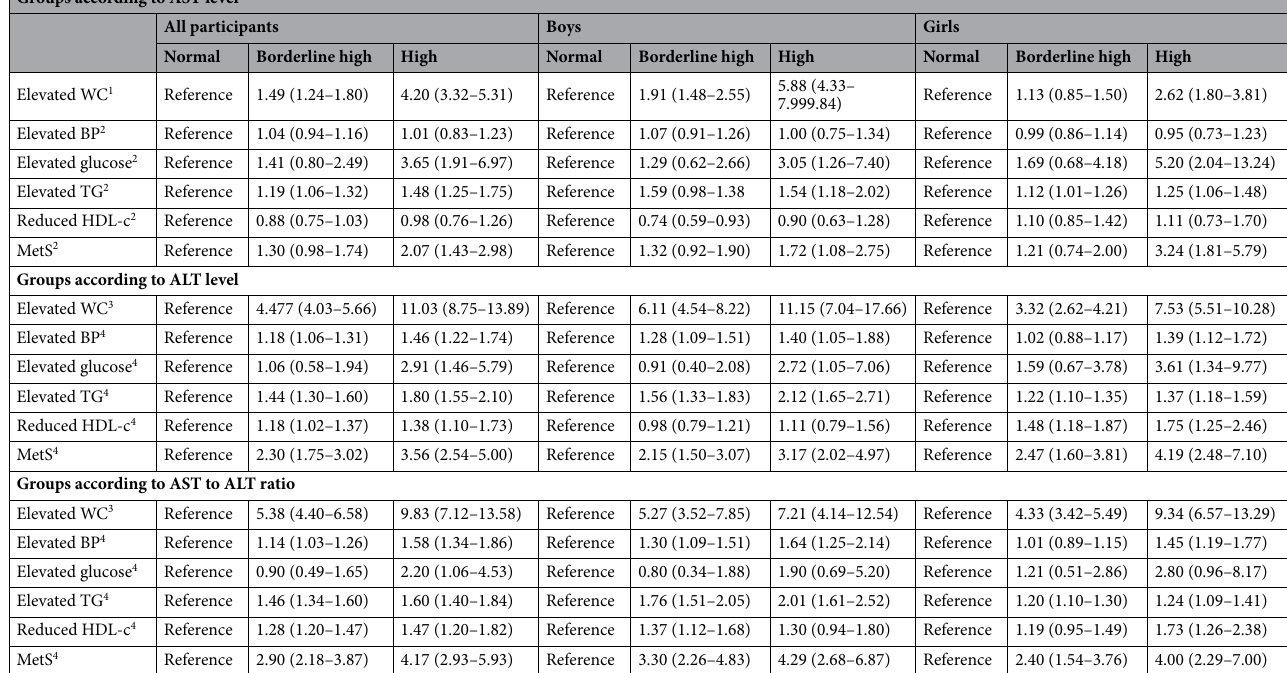
Table 4. The adjusted prevalence ratio and 95% confidence intervals of MetS and its components according to the levels of aspartate aminotransferase (AST), and alanine aminotransferase (ALT), and the AST/ALT ratio in subjects aged 10–18 years ( n = 8091). AST, aspartate aminotransferase; WC, waist circumference; BP, blood pressure; TG, triglyceride; HDL-c, high-density-lipoprotein cholesterol; ALT, alanine aminotransferase. The normal group was classified as i) aspartate aminotransferase (AST) level < 23 IU/L in boys, and < 20 IU/L in girls, ii) alanine aminotransferase (ALT) level < 19 IU/L in boys, and < 14 IU/L in girls, and iii) AST/ALT ratio > 1.10 in boys, and > 1.35 in girls. The borderline-high group was classified as i) AST level ≥ 23 IU/L and 32 < IU/L in boys, and ≥ 20 IU/L and 26 < IU/L in girls, ii) ALT level ≥ 19 IU/L and < 40 IU/L in boys, and ≥ 14 IU/L and < 23 IU/L in girls, and iii) AST/ALT ratio level < 0.65 and ≤ 1.10 in boys, and < 0.90 and ≤ 1.35 in girls. The high group was classified as i) AST level ≥ 32 IU/L in boys, and ≥ 26 IU/L in girls, ii) according to groups for AST, ALT and the AST/ALT ratio were determined using multiple logistic regression after adjustment for sex, age, alcohol consumption, smoking, physical activity, rural residence, household income, and diagnosis of hypertension, type 2 diabetes mellitus (T2DM), and dyslipidemia in all participants. Model 2: The prevalence ratio and 95% confidence interval of MetS and its components according to groups for AST, ALT, and the AST/ALT ratio were determined using multiple logistic regression after adjustment for age, body mass index (BMI) standard deviation score (SDS), alcohol consumption, smoking, physical activity, rural residence, household income, and diagnosis of hypertension, T2DM, and dyslipidemia in all participants. Model 3: The prevalence ratio and 95% confidence interval of MetS and its components according to groups for AST, ALT and the AST/ALT ratio were determined using multiple logistic regression after adjustment for age, alcohol consumption, smoking, physical activity, rural residence, household income, and diagnosis of hypertension, T2DM, and dyslipidemia in the respective sexes. Model 4: The prevalence ratio and 95% confidence interval of MetS and its components according to groups for AST, ALT, and the AST/ALT ratio were determined using multiple logistic regression after adjustment for age, BMI SDS, alcohol consumption, smoking, physical activity, rural residence, household income, and diagnosis of hypertension, T2DM, and dyslipidemia in the respective